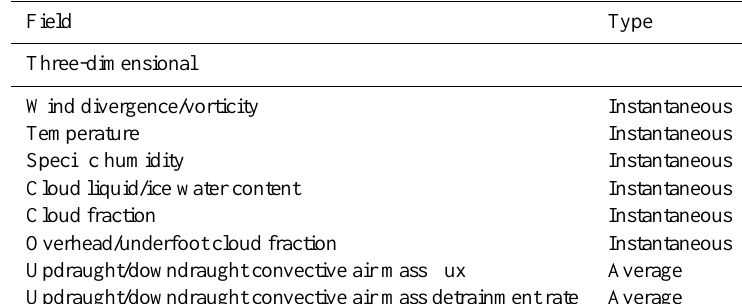
Table 1. Meteorological data and surface property fields transferred from IFS to